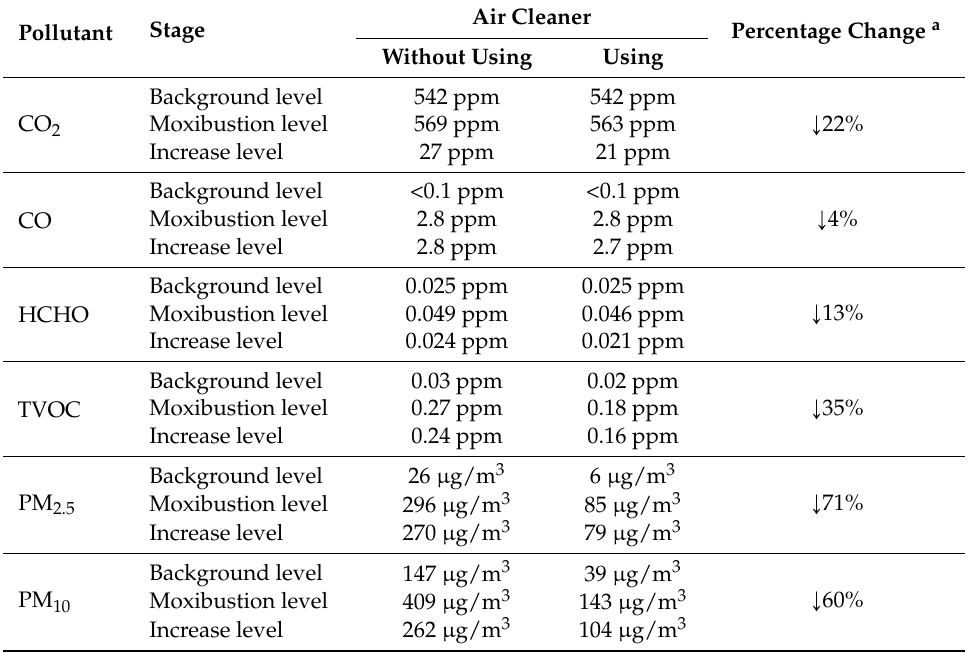
Table 3. Comparison between average values of mean levels of air pollutants emitted from burning new moxa wools with and without air